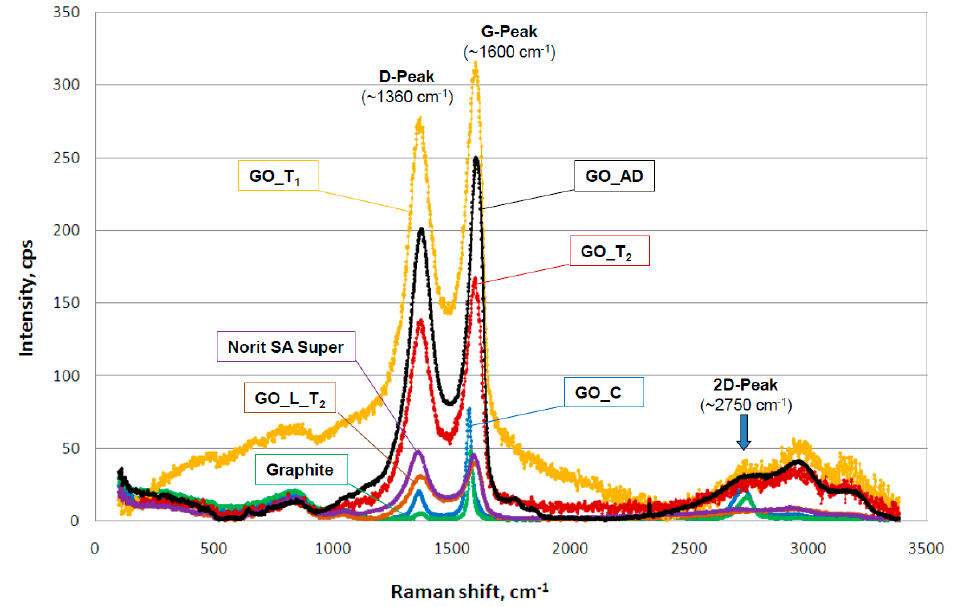
Figure 4. Raman spectra of carbon materials used in laboratory tests. Activated carbon Norit SA Super; commercial graphene oxide—GO_C, graphene oxide—GO_T 1 (after 3 weeks from synthesis time); graphene oxide—GO_T 2 (after 36 weeks from synthesis time); graphene oxide after air drying—GO_AD and GO after lyophilization—GO_L.